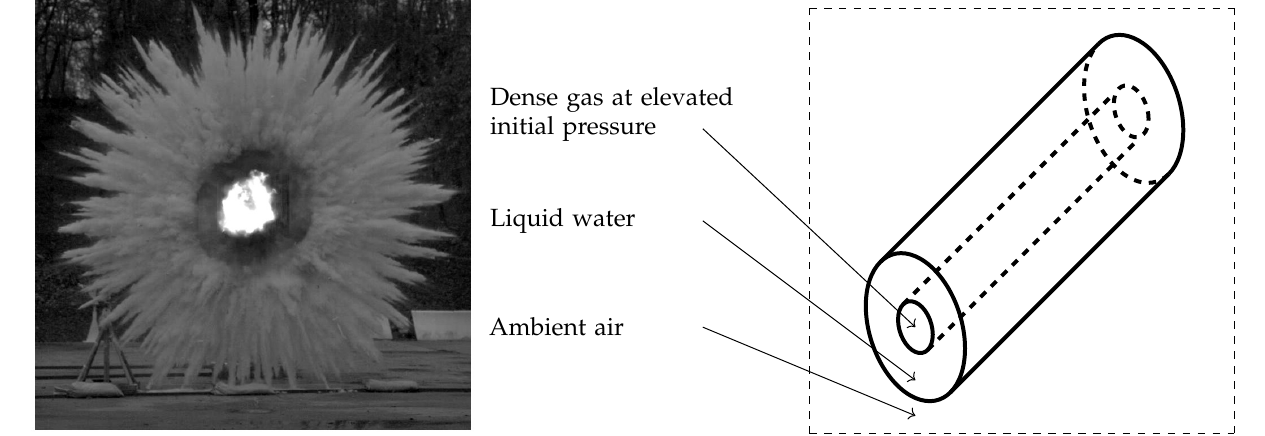
Figure 1. A cylindrical explosive charge is initially surrounded by a liquid layer. When the charge explodes the liquid layer transforms to a cloud of droplets forming highly dynamical particle jets. Experimental results are presented on the left. Same jetting effects appear when the liquid is replaced by a granular layer. These jets are present in cylindrical and spherical dispersal explosions. On the right, a schematic representation of the initial cylindrical gas-liquid explosive system is depicted. The internal cylinder is initially filled with a dense gas at high pressure. The external cylinder is initially filled with liquid water at atmospheric pressure. Atmospheric air surrounds both cylinders. Material interfaces are initially